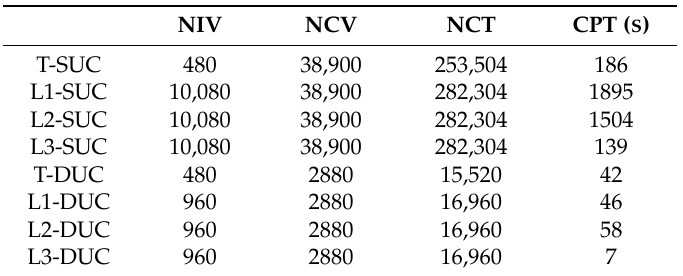
Table 10. Computational performance for different UC formulations.